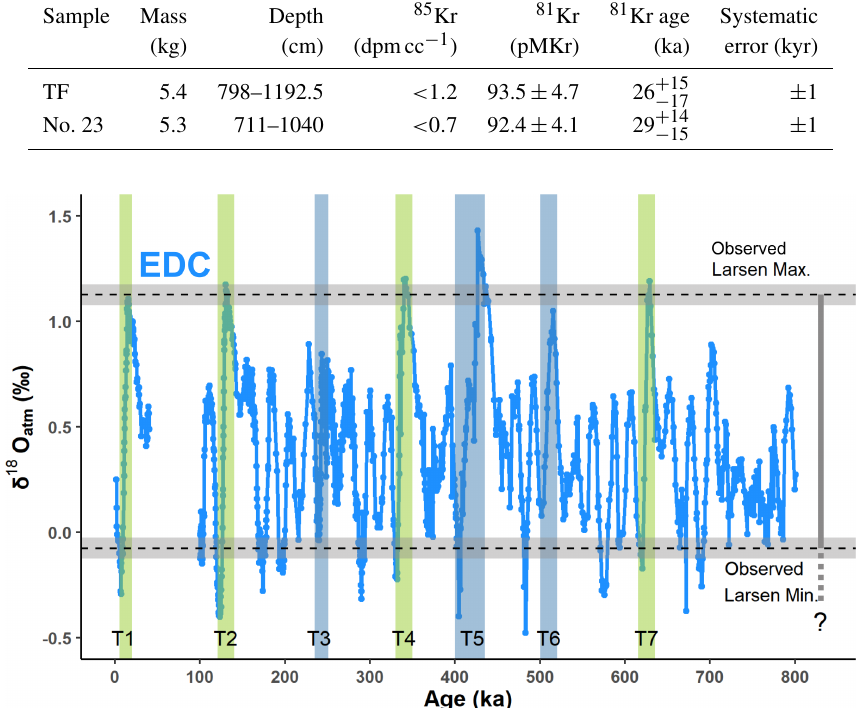
Figure 5. Comparison of Larsen δ 18 O atm with the EDC record. δ 18 O atm records are from Landais et al. (2013) for 0–40ka and Extier et al. (2018a) for 100–800ka, respectively. Green vertical bars represent the candidate age intervals for Larsen blue ice. T: termination. The range of Larsen δ 18 O atm values is shown as a vertical grey bar. Horizontal grey bars with dashed lines represent the uncertainty in the measured δ 18 O atm from the Larsen BIA (Fig.